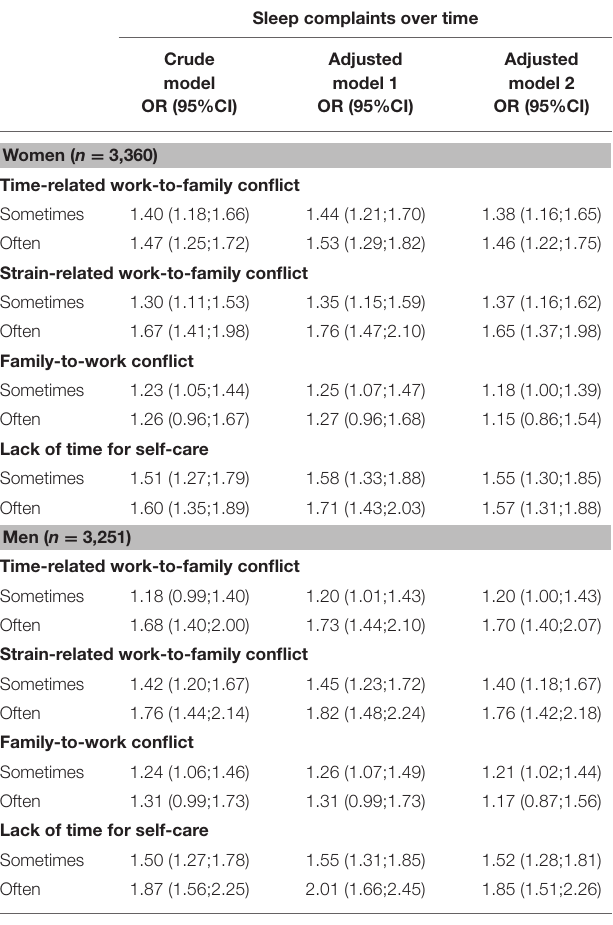
TABLE 2 | Cross-sectional associations between work-family conflict, lack of time for self-care and sleep complaints at baseline. Baseline sleep complaints